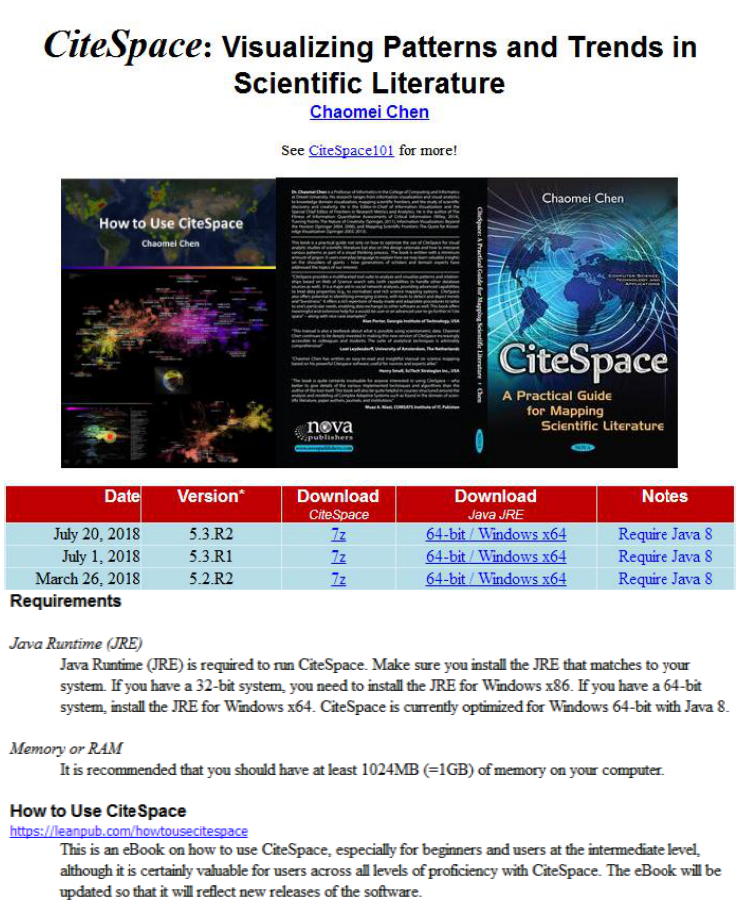
Figure 1. Download interface of CiteSpace software.